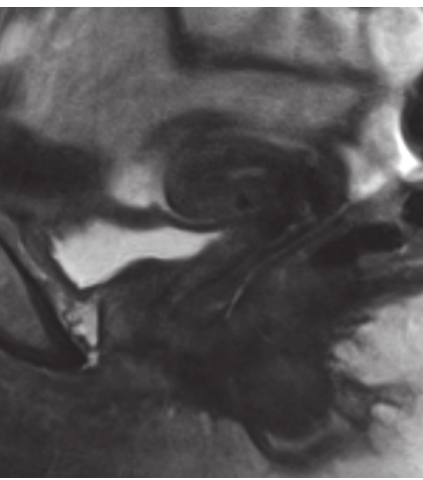
Figure 1: Sagittal MRI in Case 1 showing uterus, cervix, and vagina after